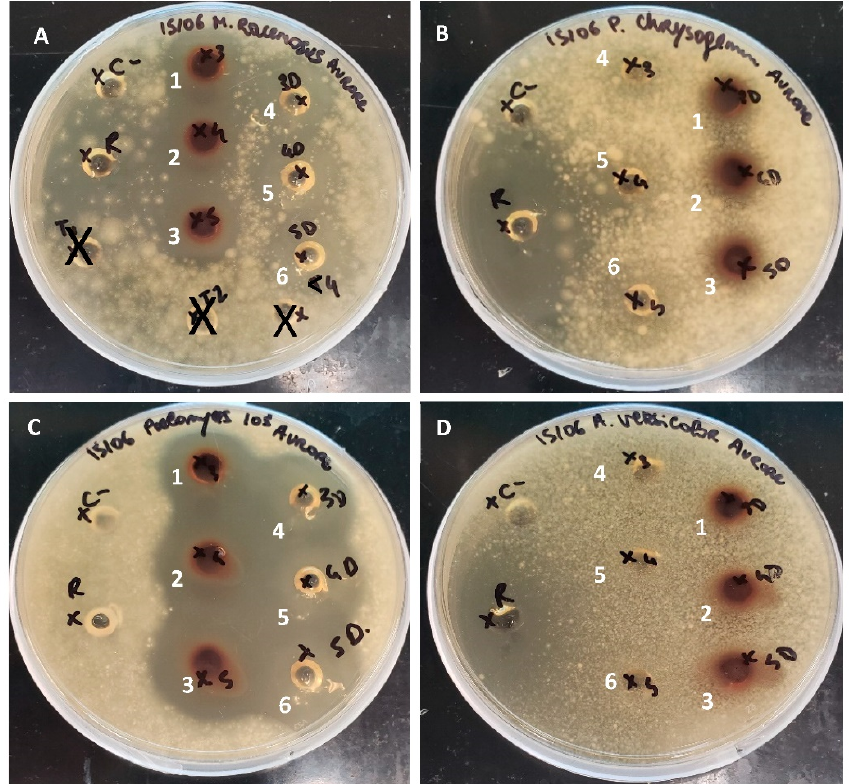
Figure 7. Inhibition zones for molds M. racemosus ( A ) P. chrysogenum ( B ) Paecilomyces spp. ( C ) A. versicolor ( D ) distilled water (C –) and Reuterin (R). 1 2 and 3: Raw hydrolysate repetition 1 2 and 3; 4 5 and 6: Discolored hydrolysate repetition 1 2 and 3; X: samples not relevant to the study.